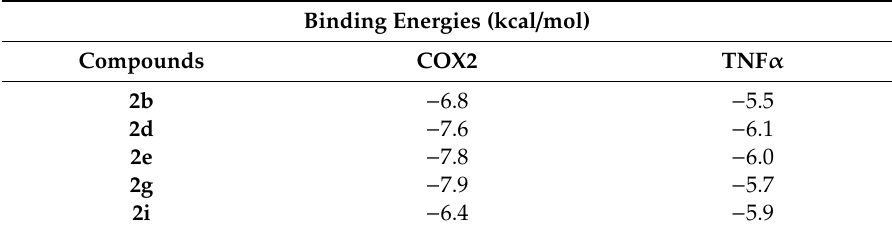
Table 1. Binding energy values of docking. TNF, tumor necrosis factor; COX,cyclooxygenase.